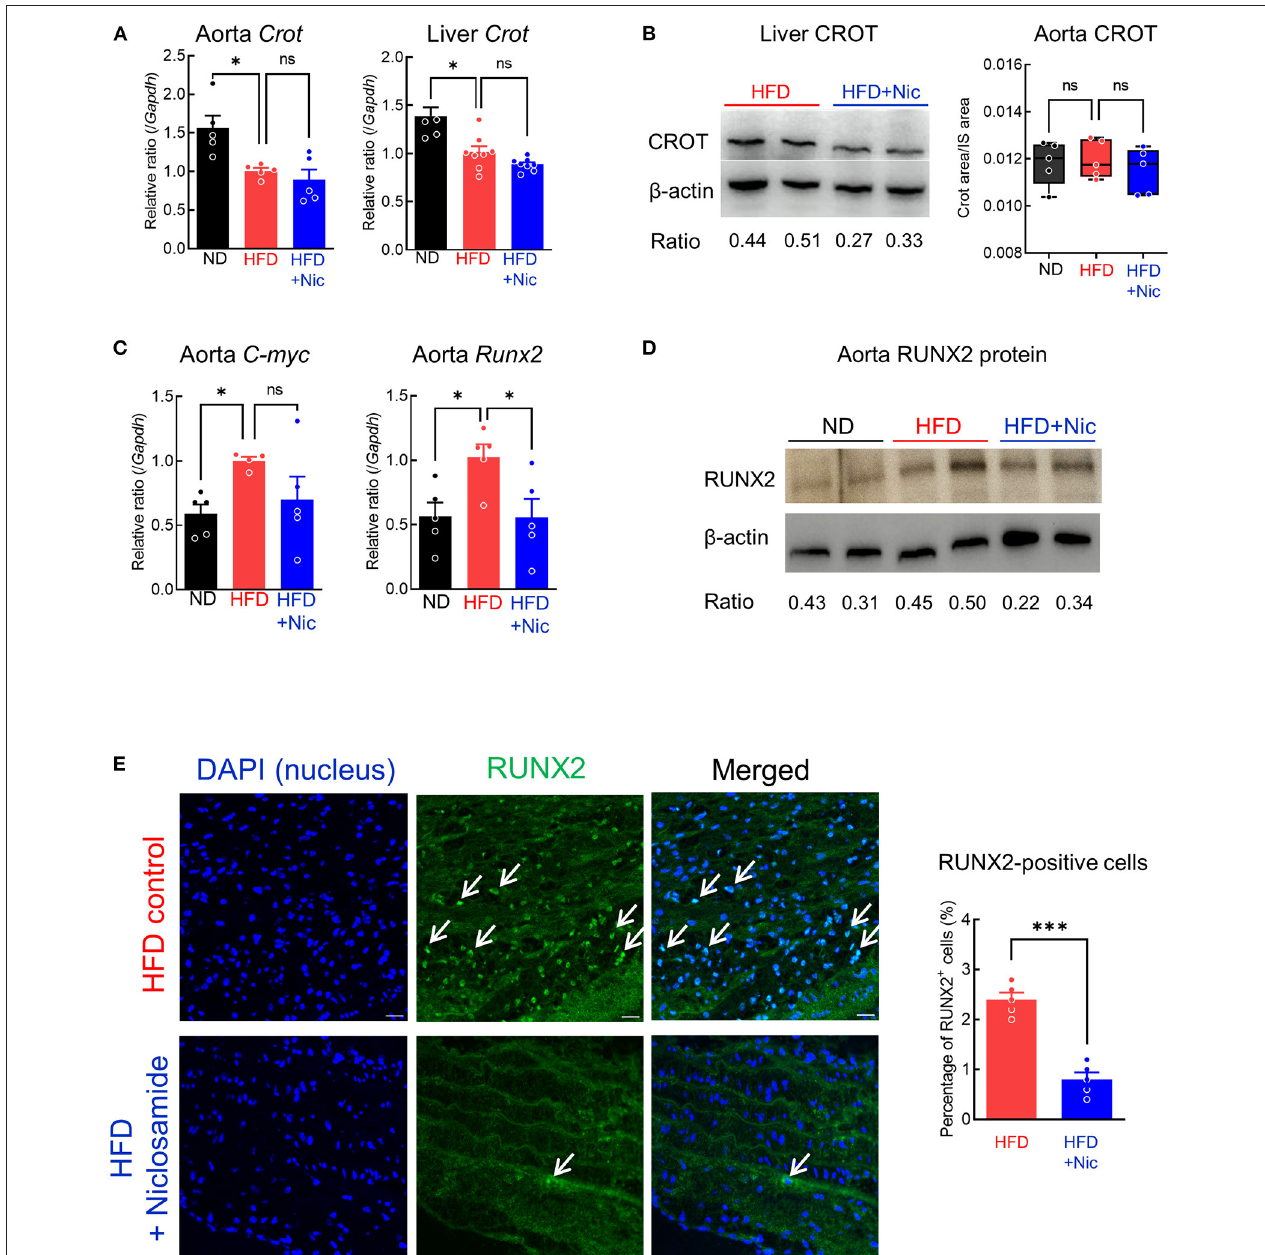
FIGURE 4 | Niclosamide reduces Wnt signaling and Runx2 expression in the mouse aorta. (A) Crot transcript levels in the aorta and liver of mice treated with ND, HFD for 15 weeks or HFD containing niclosamide for 10 weeks. N = 5 (for the aorta) or 8 (for the liver) mice per group, error bars are mean ± SD, analyzed by ANOVA followed by Dunnett’s multiple comparison test, * P < 0.05. (B) CROT protein levels in liver (Western blot) and the aorta (targeted mass spectrometry) of mice treated with ND, HFD and HFD containing niclosamide. Western blotting with anti-CROT antibody with liver sample (left, N = 2) from mouse treated HFD and HFD containing niclosamide. Average signal intensity ratio of CROT/ β -actin are shown. CROT-targeted mass spectrometry peak area ratio in the aorta tissue (right), N = 5 mice per group analyzed by ANOVA-Dunnett’s multiple comparison test, ns indicates not significant. (C) c-myc and Runx2 transcript levels in the aorta of mice treated as in (A) . N = 5 mice per group, error bars represent mean ± SD, analyzed by ANOVA with Dunnett’s multiple comparison test, * P < 0.05. (D) Western blotting with RUNX2 antibody with aorta samples from mice treated as in (A) ( N = 2). Average signal intensity ratio of RUNX2/ β -actin are shown. (E) Representative immunofluorescence images using anti-RUNX2 antibody for aorta tissue from mice treated as in (A) . Nuclei RUNX2 expression are shown (white arrows). Scale bars = 20 µ m. RUNX2 positive cell number quantification shown in graph, N = 5 mice per group, analyzed by Student t -test. *** P < 0.001.